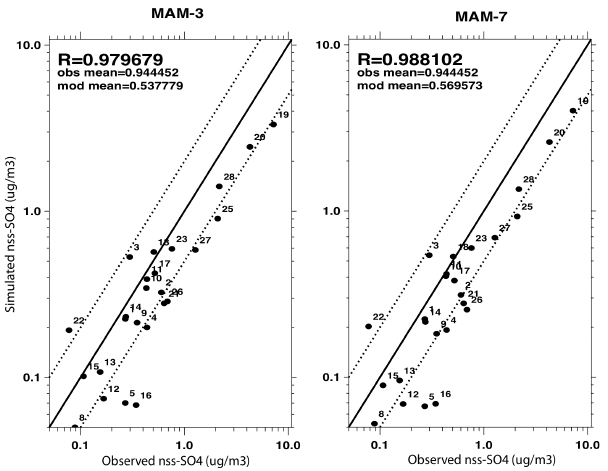
Fig. 10. Observed and simulated annual-average non-sea salt sulfate (nss-SO 4 ) concentrations (µgm − 3 ) at marine sites operated by the Rosenstiel School of Marine and Atmospheric Science (RSMAS) at the University of Miami. Observations are for site-available years between 1981–1998. Simulated values for MAM3 (left) and MAM7 (right) are from model lowest layer, and the Tenerife mountain site is not included. The global locations of sites denoted by different numbers in the figure can be found in Wang et al. (2011).